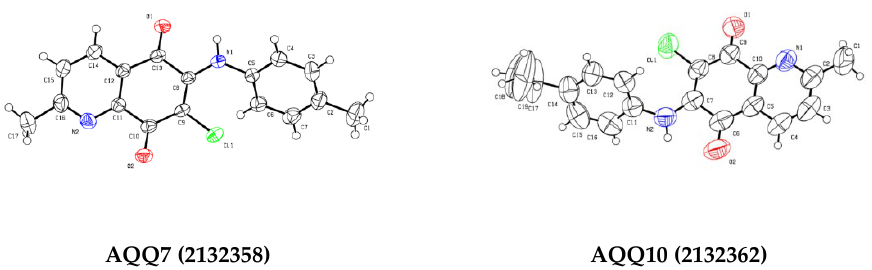
Figure 4. ORTEP drawings of the AQQ7 and AQQ10, the atom numbering at 50% probability level. Table 1. Crystallographic data for the AQQ7 and AQQ10 .